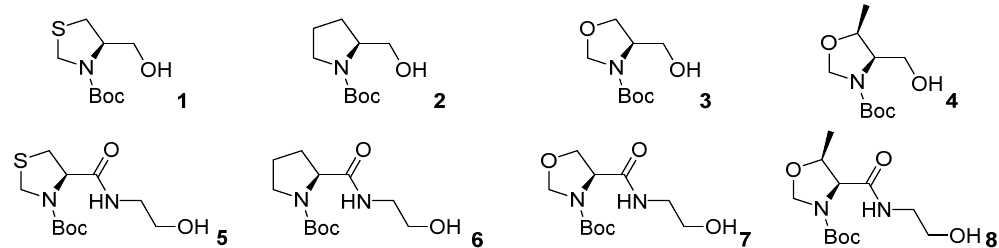
Figure 1. Structure of the different compounds used as initiators for ε -caprolactone polymerization.